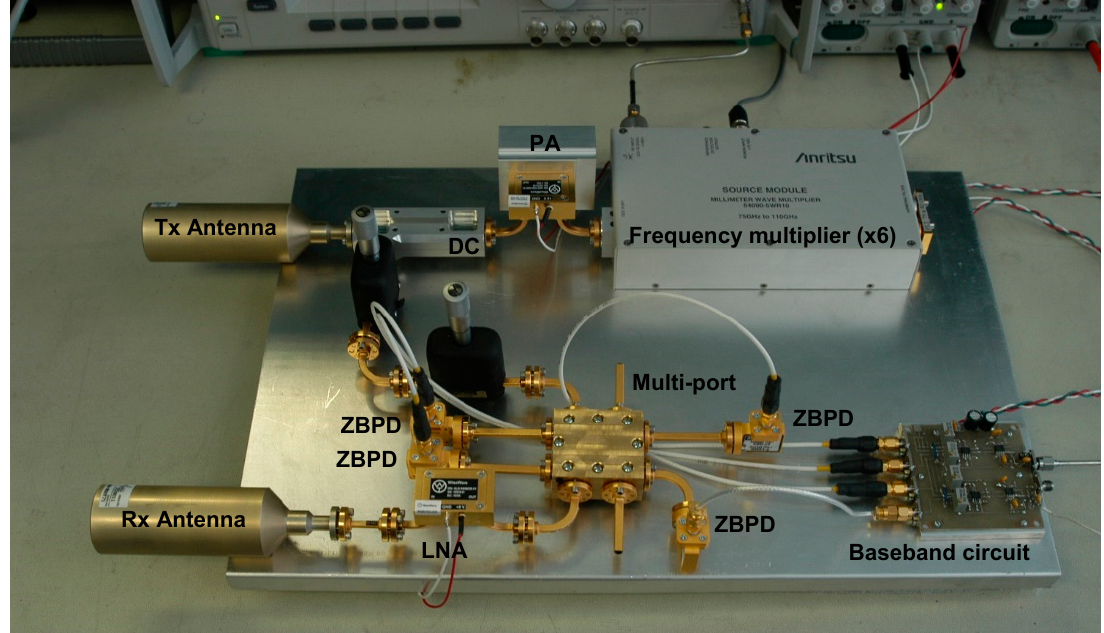
Figure 8. Photo of the 94 GHz radar sensors with WR-10 waveguide components and modules.